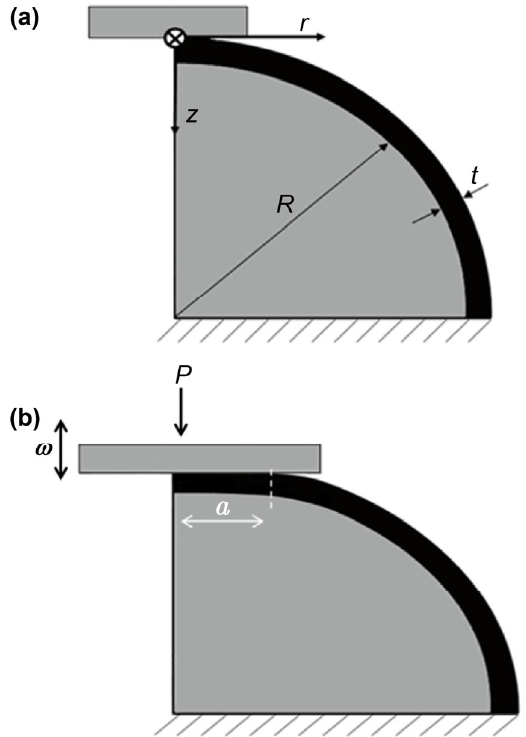
Fig. 1 Schematic of a coated deformable sphere pressed by a rigid flat, before loading (a) and in contact after loading (b) (taken from Ref.